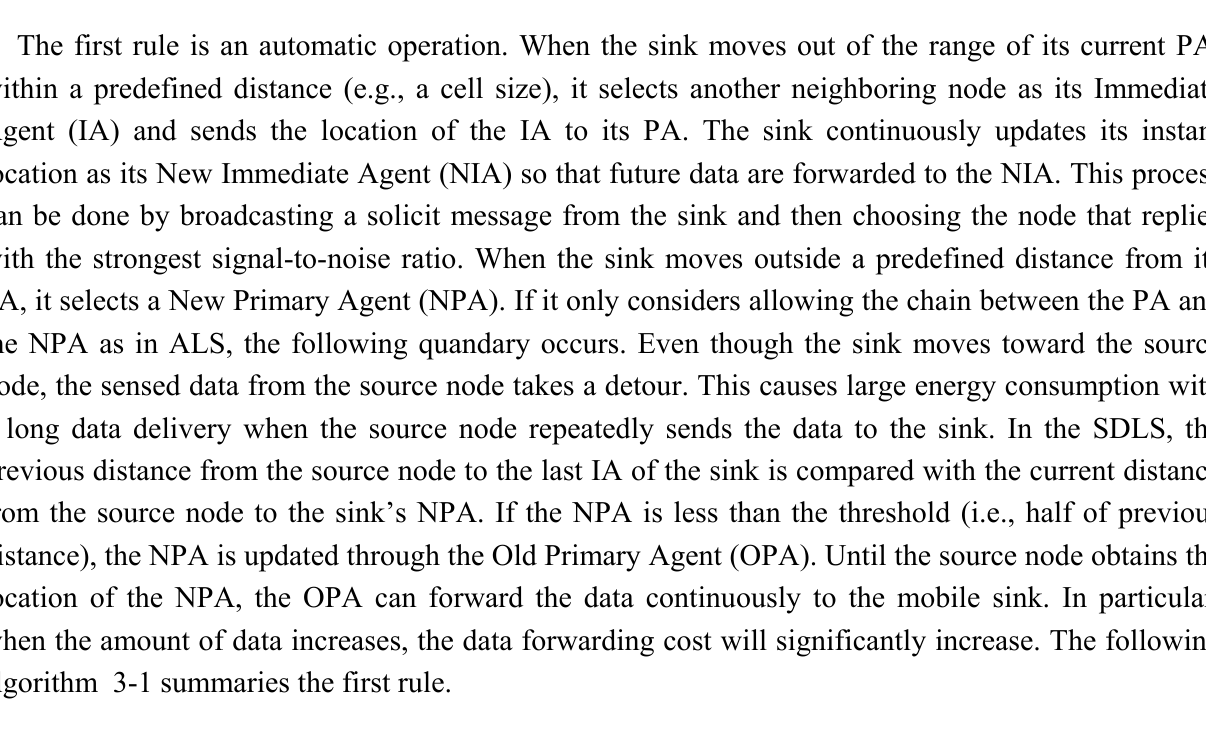
Algorithm 3-1. Pseudo-code to automatic